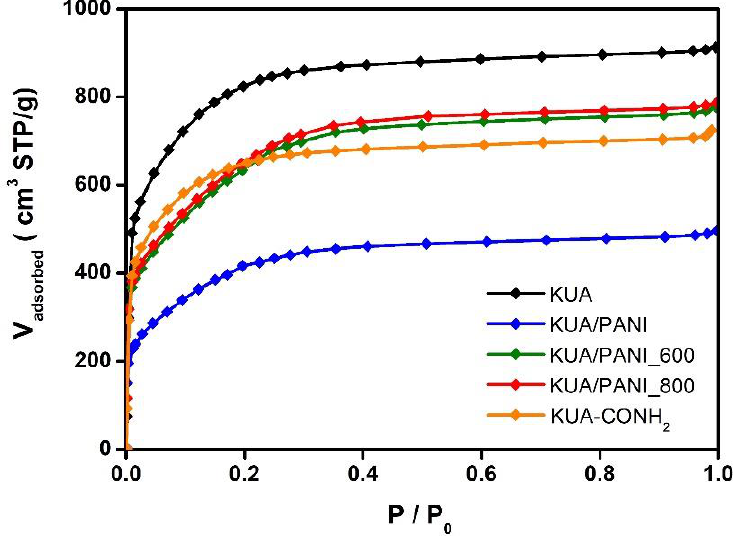
Figure 3. N 2 adsorption isotherms obtained for KUA (pristine sample), KUA/PANI composite and N-doped activated carbons.